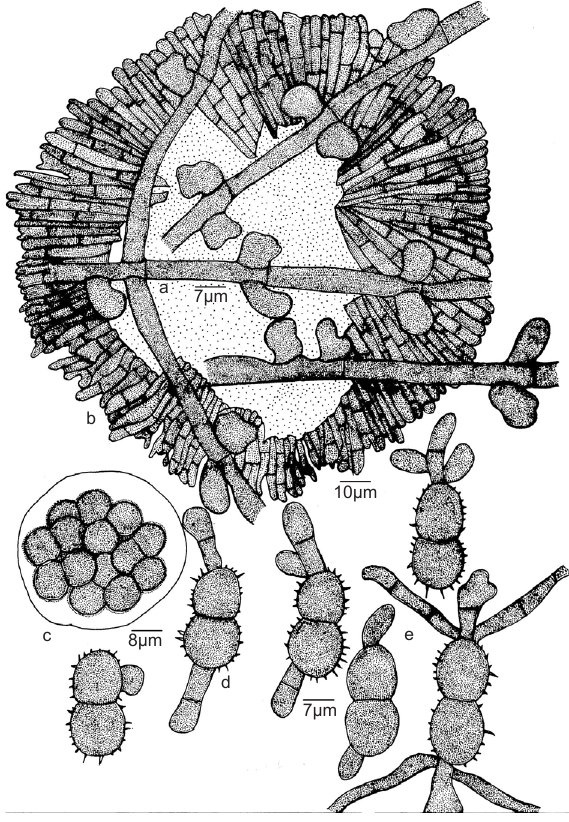
Figure 3. Asterina myristicacearum sp. nov. a - Appressoriate mycelium; b - Thyriothecium; c - Ascus; d - Germinating